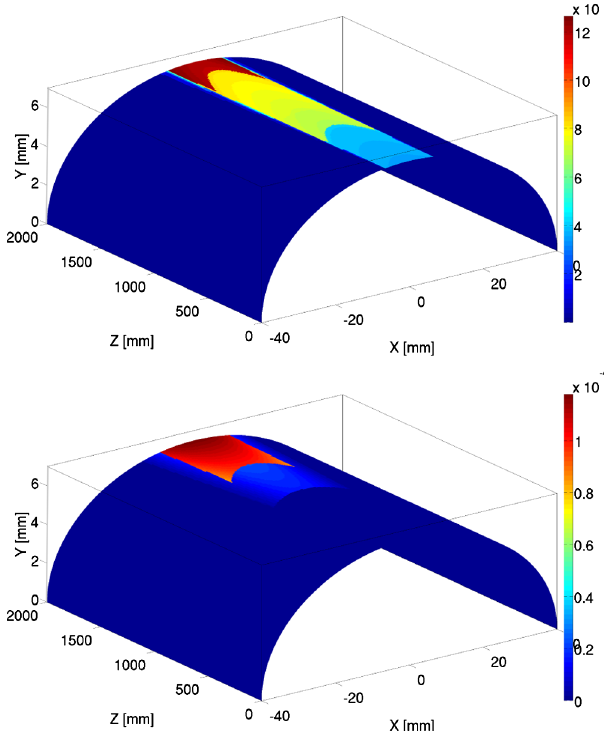
FIG. 12. Spatial distribution of synchrotron radiation on the beam pipe for the 25th wiggler with a total heat load of 40 W (top) and the 26th wiggler with a total heat load of 2 W (bottom) for the Nb-Ti baseline design (units: W = mm 2 ).